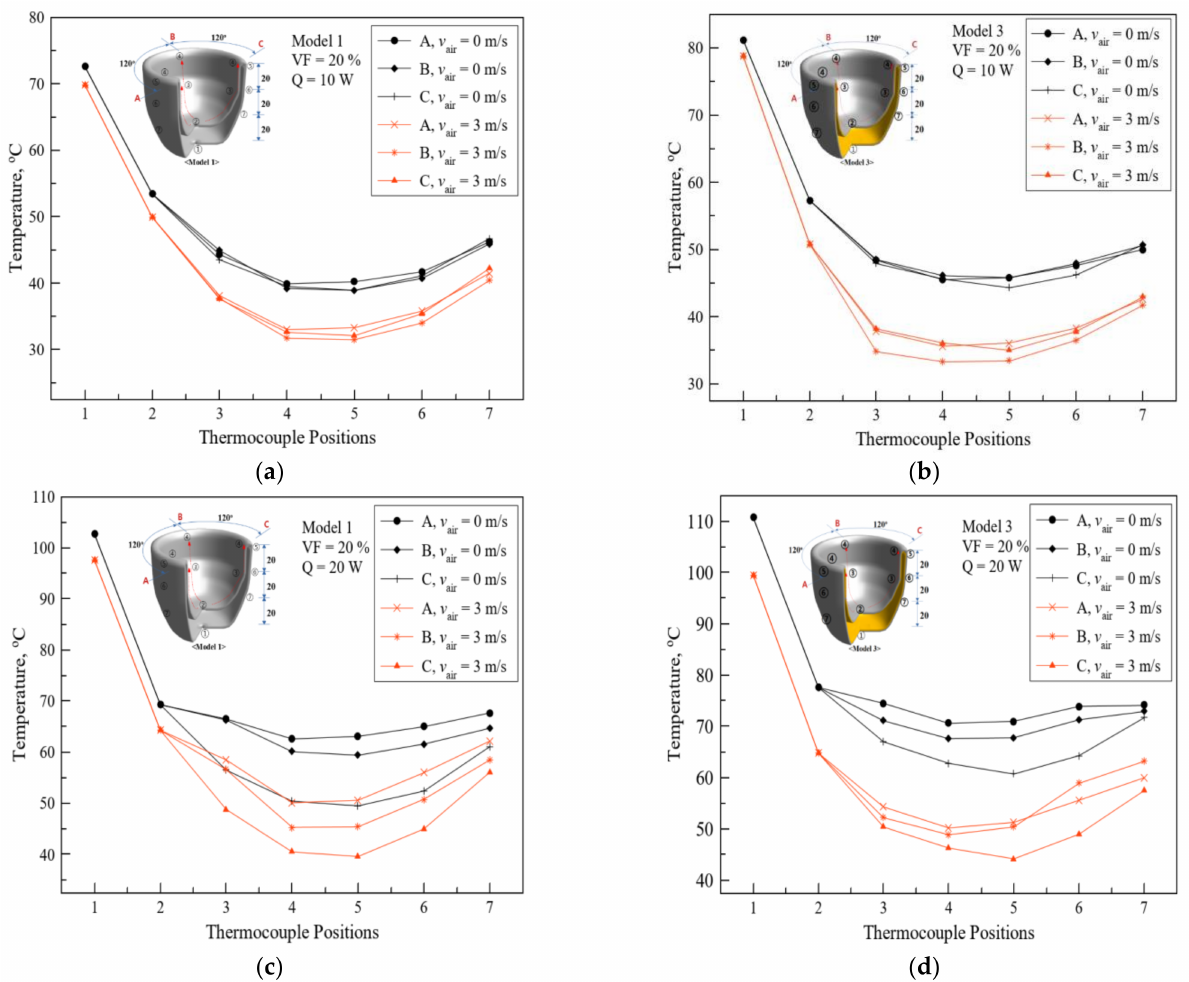
Figure 9. Temperature profile in three directions of the HSVC. ( a ) Model 1, Q = 10 W. ( b ) Model 3, Q = 10 W. ( c ) Model 1, Q = 20 W. ( d ) Model 3, Q = 20